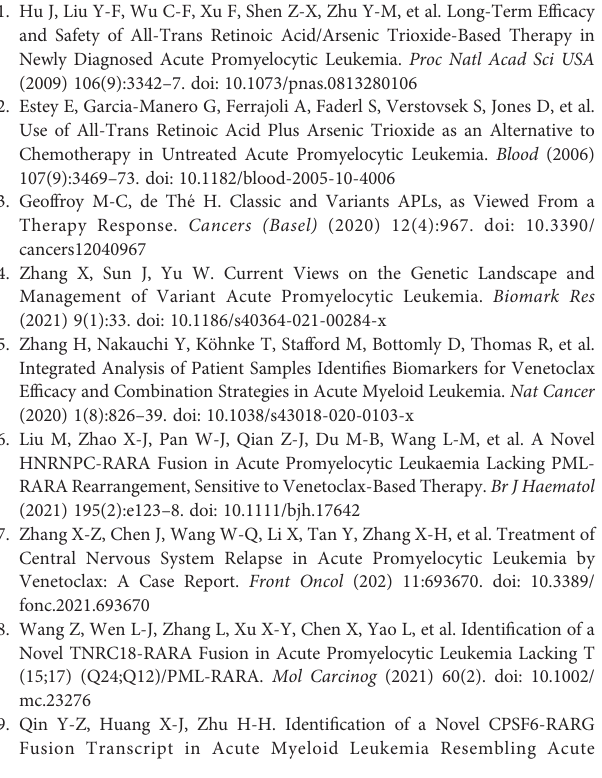
genes) (A) and RARA-THRAP3 fusion transcript (exon 9 of THRAP3 and exon 6 of RARA genes) (B)